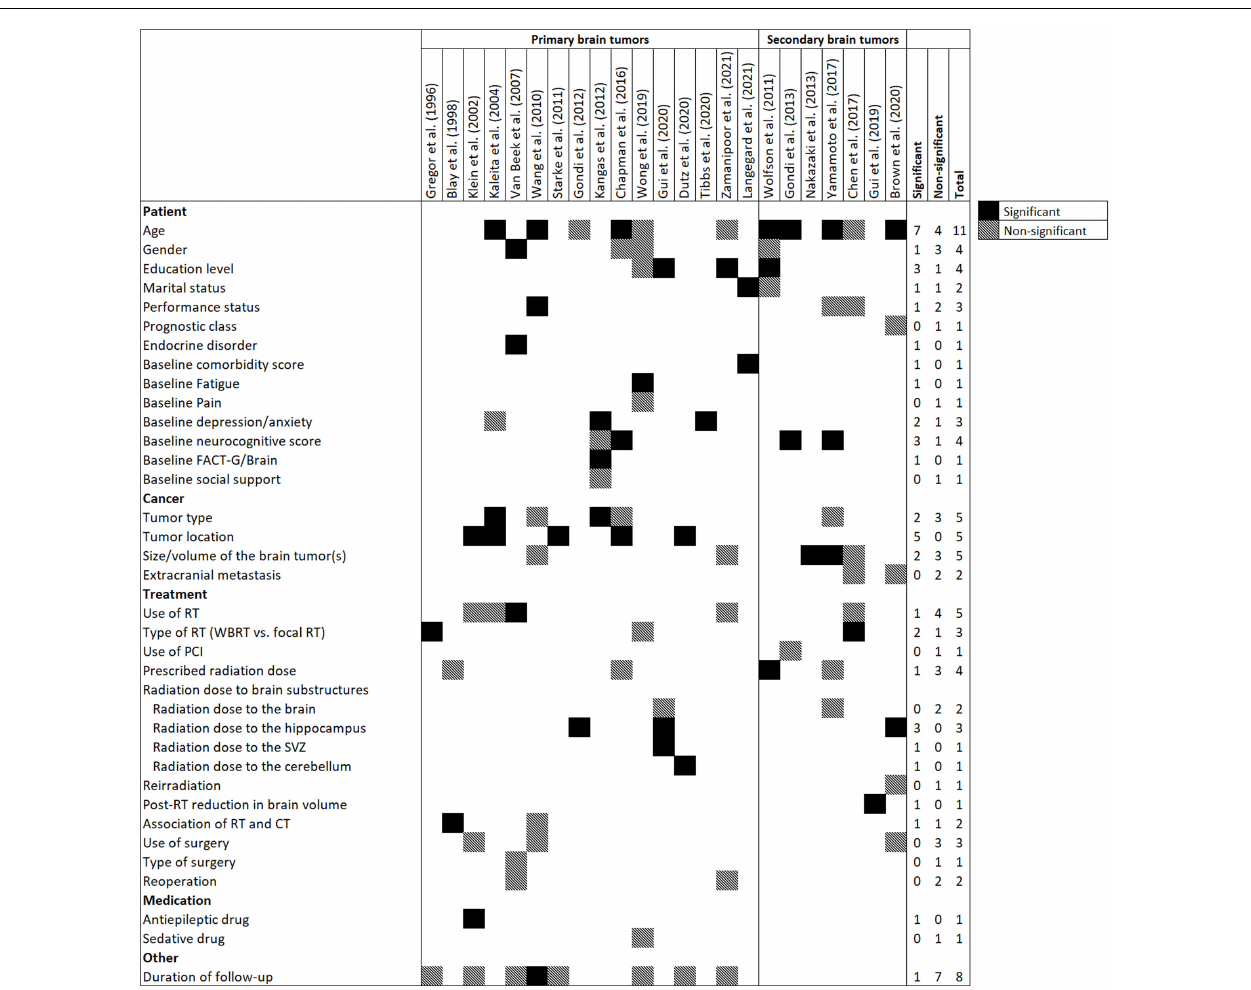
FIGURE 2 | Frequency of candidate and significant predictors in prediction models for radiation-induced neurocognitive decline in patients with primary or secondary brain tumors. Abbreviations: CT, Chemotherapy; FACT-G, Functional Assessment of Cancer Therapy-General; PCI, prophylactic cranial irradiation; RT, Radiotherapy; SVZ, subventricular zone; WBRT, Whole brain